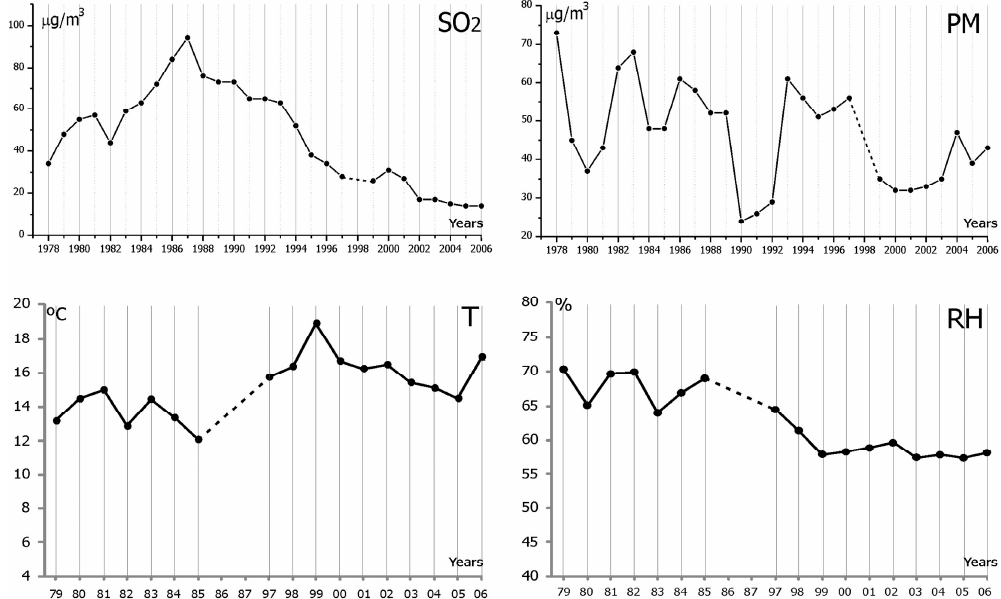
Figure 3. Yearly SO 2 and particulate matter (PM) concentration, temperature (T) and relative humidity (%) in 1978/79–2006, measured at the air pollution and weather stations nearest the former hospital (dashed lines = no data available) (sources: Madrid Municipal Air Protection Service’s environmental information system and Spanish Meteorological Agency’s Weather Information Unit).